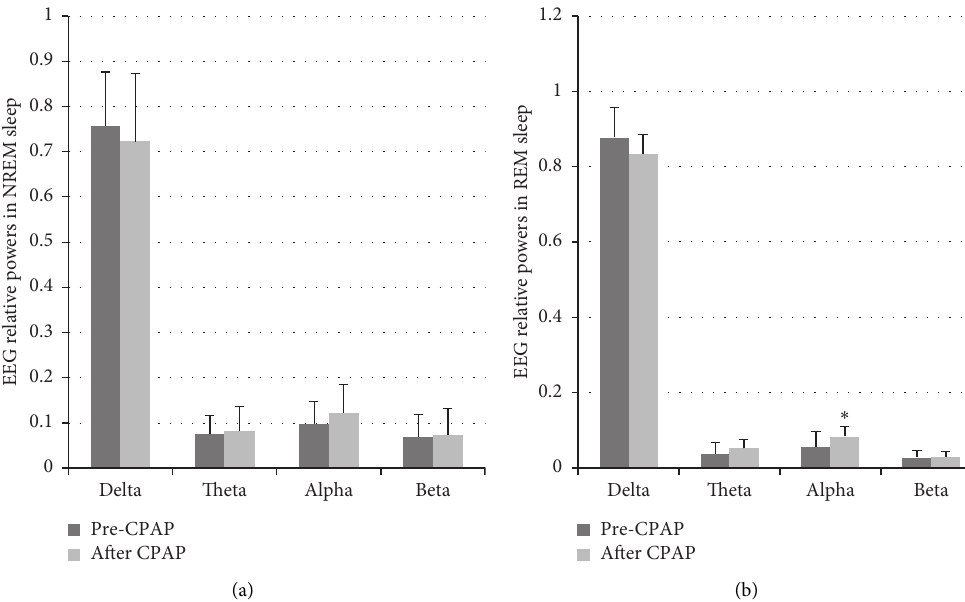
Figure 2: The changes of sleep EEG spectral power before and after CPAP in patients with CSAS in nonrapid eye movement (NREM) sleep (a) and rapid eye movement (REM) sleep. (b) ∗ p < 0 . 05 vs. before